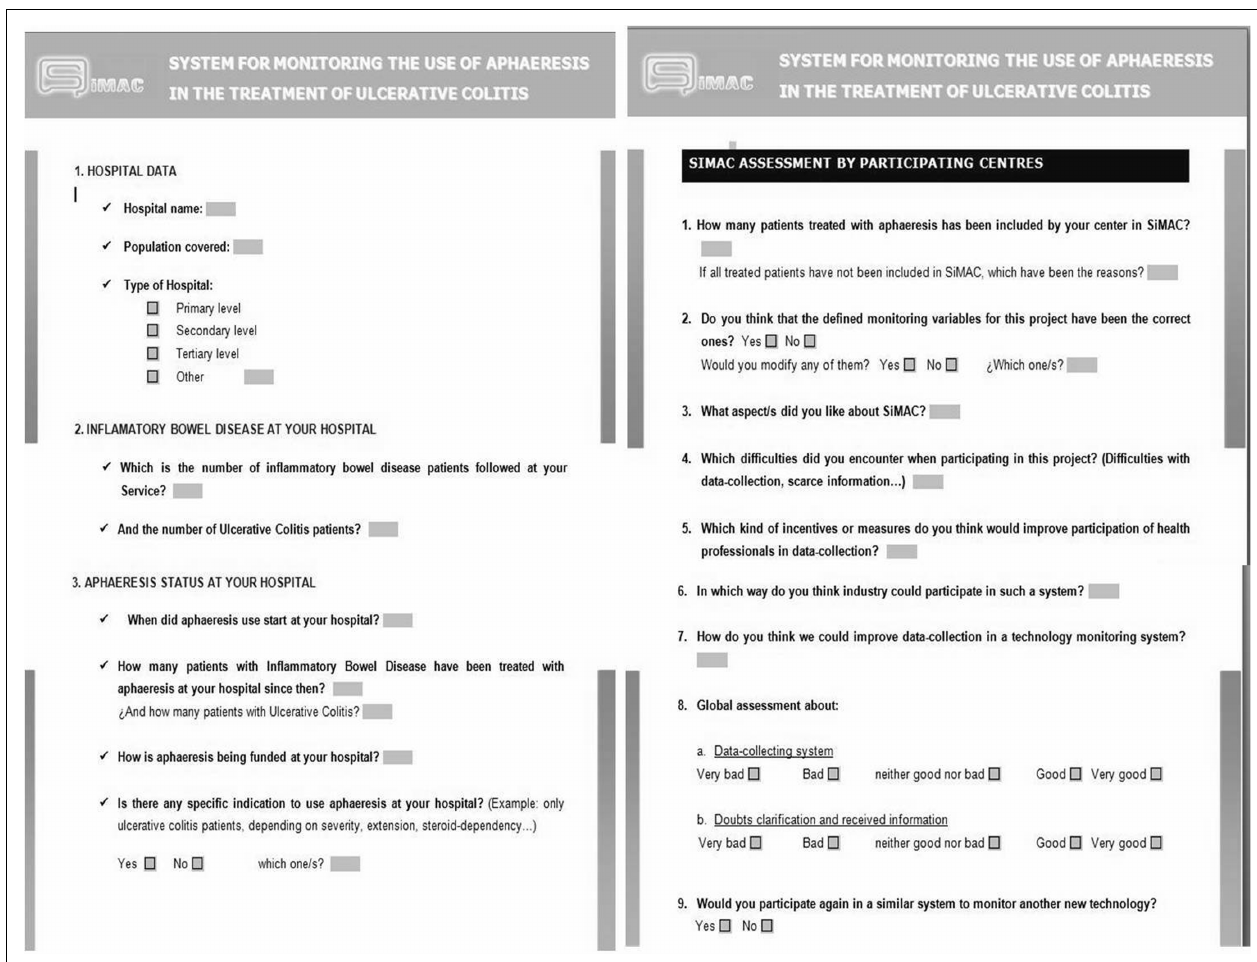
FIGURE 1 | System for monitoring aphaeresis in ulcerative colitis assessment questionnaire. The outcomes of the questionnaire had not been